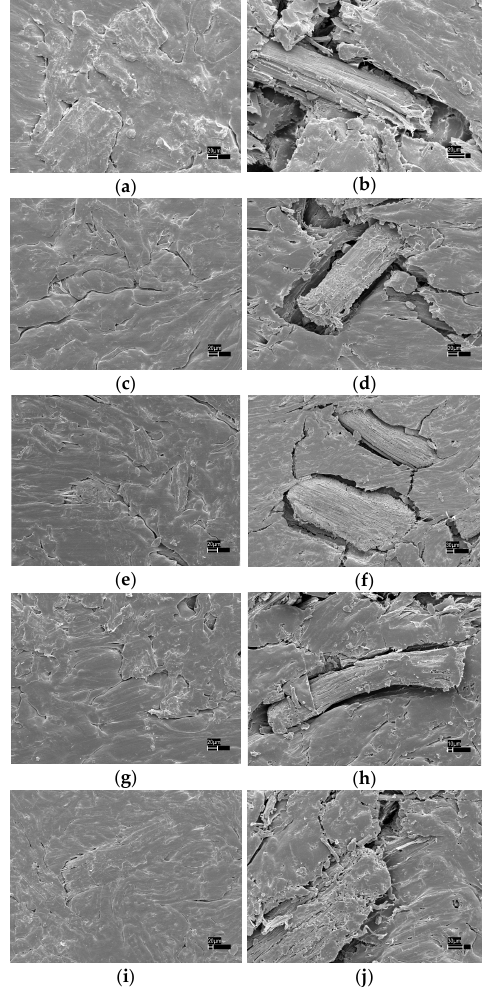
Figure 7. Morphology of the WPCs before and after weathering. ( a ) Control before weathering; ( b ) Control after weathering; ( c ) TE before weathering; ( d ) TE after weathering; ( e ) AW before weathering; ( f ) AW after weathering; ( g ) HW before weathering; ( h ) HW after weathering; ( i ) LR before weathering; ( j ) LR after weathering.